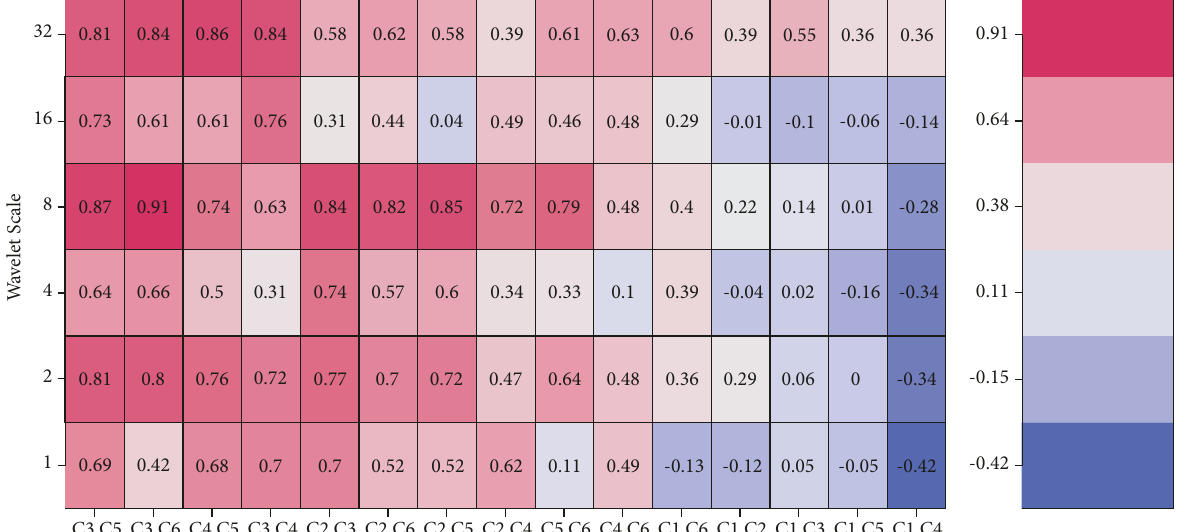
C3 Figure 8: Wavelet bivariate correlations matrix (18/08/2010–03/11/2020). The codes for the variables are China (C1), India (C2), Indonesia (C3), Malaysia (C4), Thailand (C5), and Taiwan